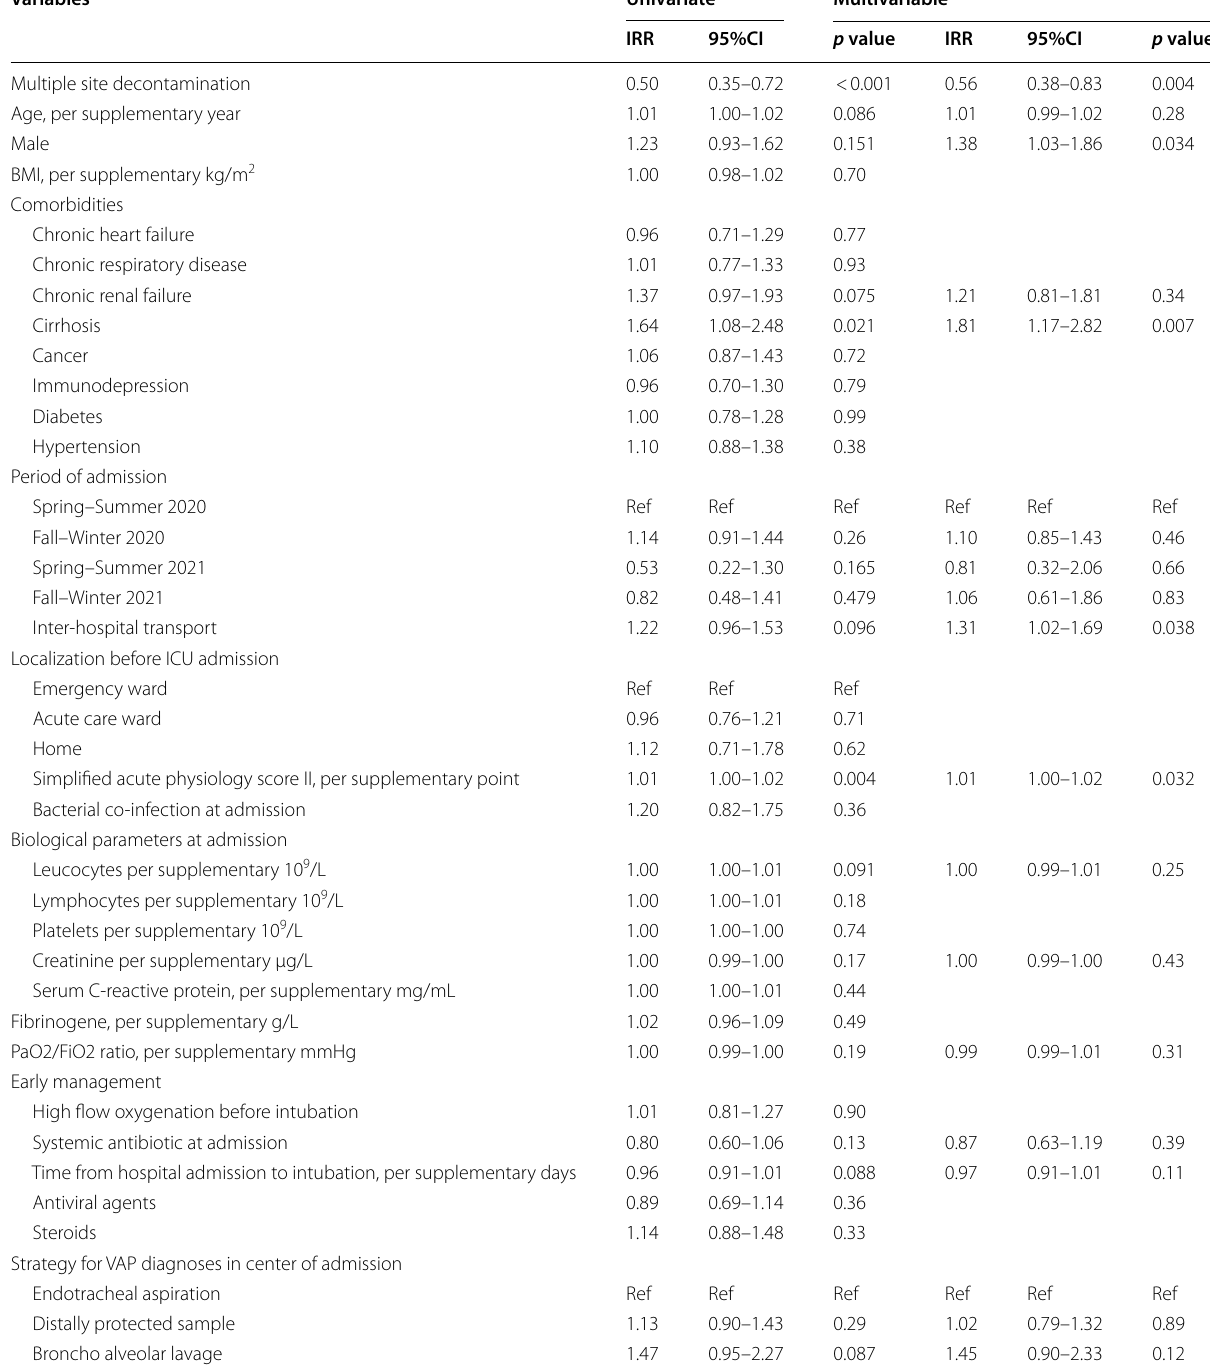
Table 2 Risk factors for ICU acquired